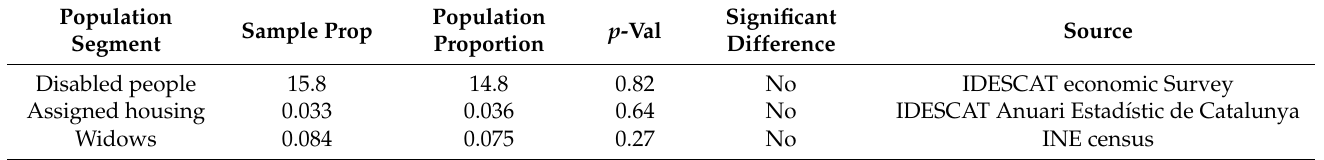
Table 6. Validation. Sample proportion against Population Proportion.